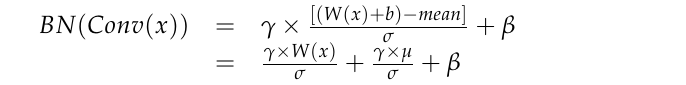
where W() denotes the convolution kernel operation, b is the bias, γ is the scaling factor, β is the bias, σ is the standard deviation, and µ = b − mean is the cumulative mean.